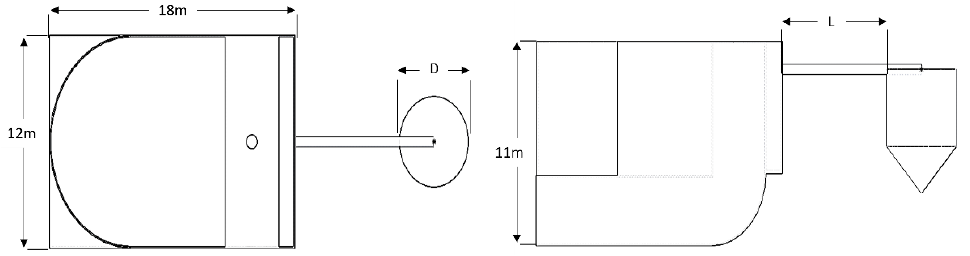
Figure 8. Top View ( Left ) and Side View ( Right ) of the Model with Dimensions.